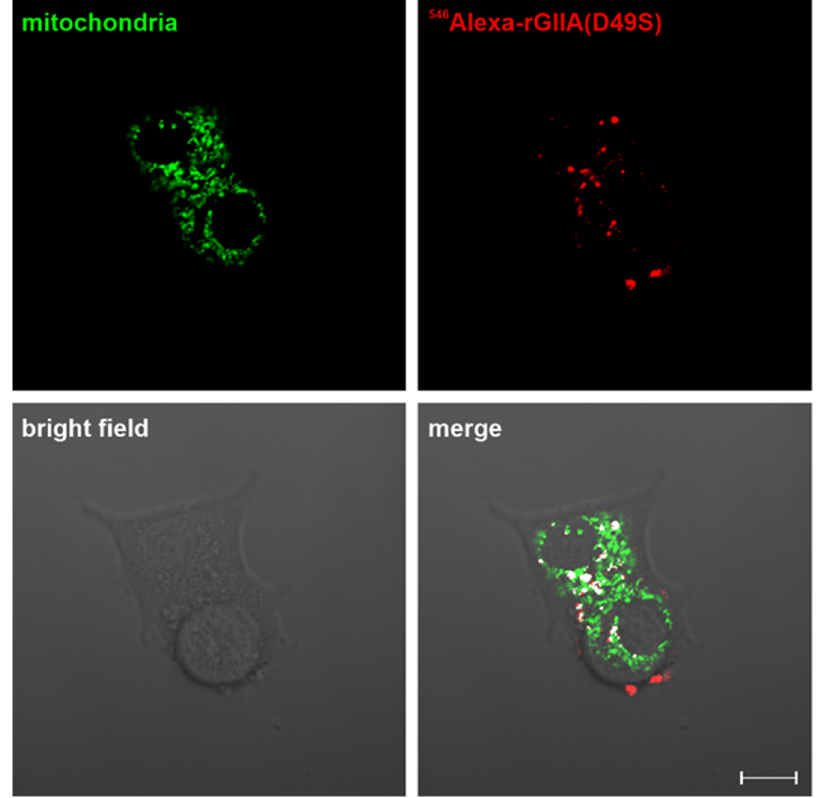
Figure 4. rGIIA can reach mitochondria in PC12 cells from the extracellular space independently of its enzymatic inactivity. PC12 cells were incubated with 100 nM 546 Alexa-rGIIA(D49S) for 3 h and mitochondria were labeled with MitoTracker Green FM dye. Cells were then analyzed with confocal microscopy. Representative confocal fluorescence microscopy image shows 546 Alexa-rGIIA(D49S) (red) and MitoTracker-labeled mitochondria (green); colocalization in merged image is shown in white. The extent of colocalization of 546 Alexa-rGIIA(D49S) and mitochondria in PC12 cells, expressed in terms of the Manders’ coefficient, was 0.05 ± 0.01, mean ± S.E.M., as calculated from 7 images. Scale bar, 10 µm.